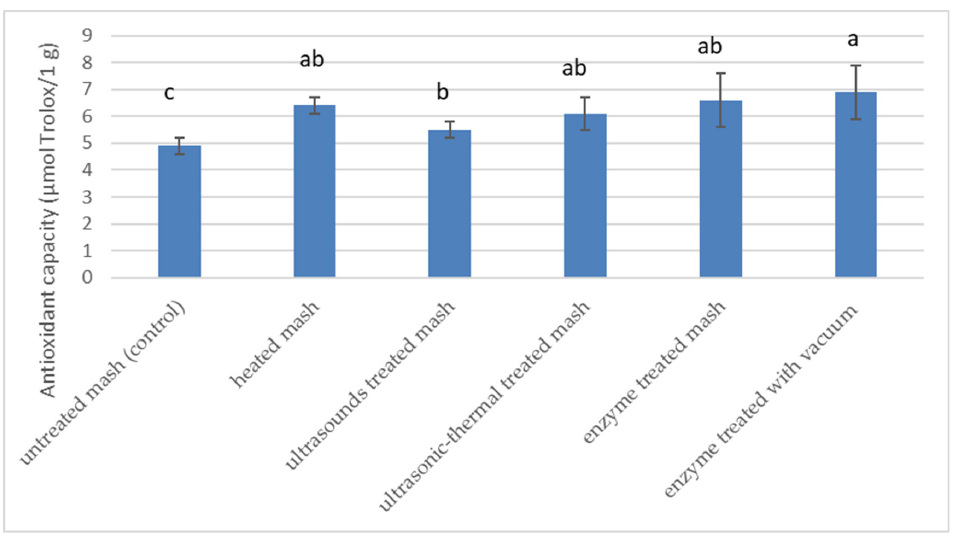
Table 3. Pearson ’ s correlation coefficients .